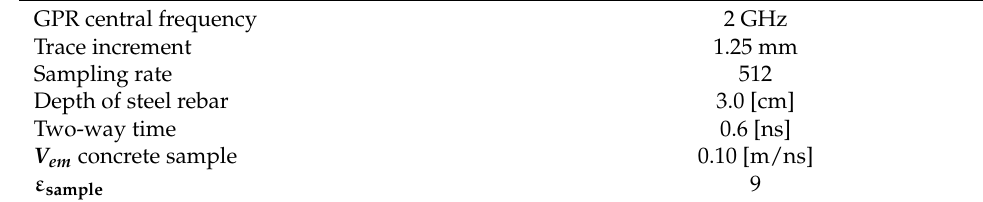
Table 2. GPR sample and acquisitions parameters.